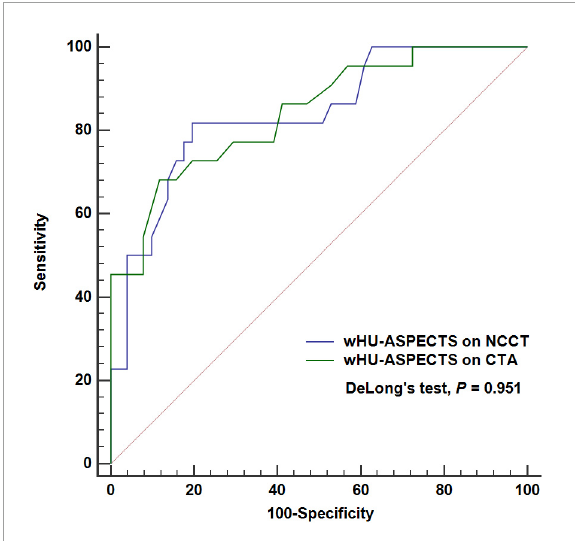
FIGURE5 ROC analysis of attenuation changes on NCCT vs. CTA to classify ischemic extent ≥ 70 ml. The wHU-ASPECTS on NCCT image had an AUC of 0.842 ( P < 0.001), not significantly different from that based on NCCT (AUC = 0.838, P < 0.001), with DeLong’s test analysis ( P = 0.951). ASPECTS indicates Alberta Stroke Program Early CT Score; wHU-ASPECTS, sum of the products of regional relative HU values times corresponding weighting